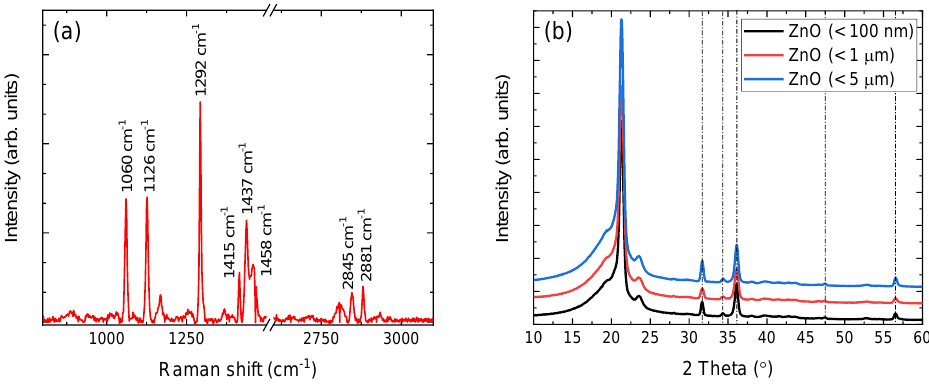
Figure 2. ( a ) Raman shift lines of LDPE in ZnO (< 5 µ m) containing film, with an axis break for clarity. ( b ) XRD patterns of ZnO dispersoids embedded in LDPE. Nanoparticle sizes of < 100 nm (black), < 1 µ m (red), and < 5 µ m (blue) are shifted vertically for